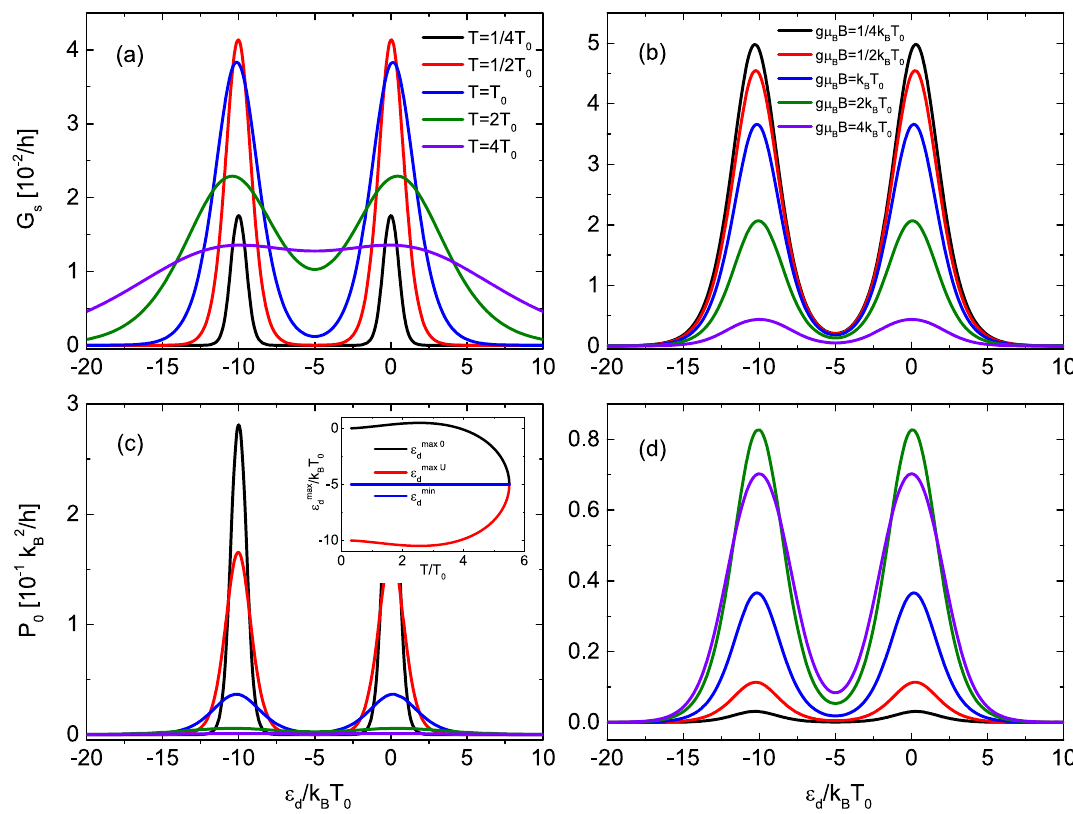
Figure 4. Spin conductance and spin power factor in the case of finite U . Spin conductance and corresponding power factor as a function of the dot’s level position calculated for indicated values of temperature ( a ) and ( c ) k B T 0 and the applied magnetic field ( b ) and ( d ) and for k B T k B T 0 . Inset shows temperature and for g µ B B = = dependence of dot’s energy level for which spin conductance achieves maximum (black and red) and minimum 10 k 0.1 k 0.1 (blue). The other parameters are: U B T 0 , Ŵ e = Ŵ m = B T 0 and k B T 0 = =